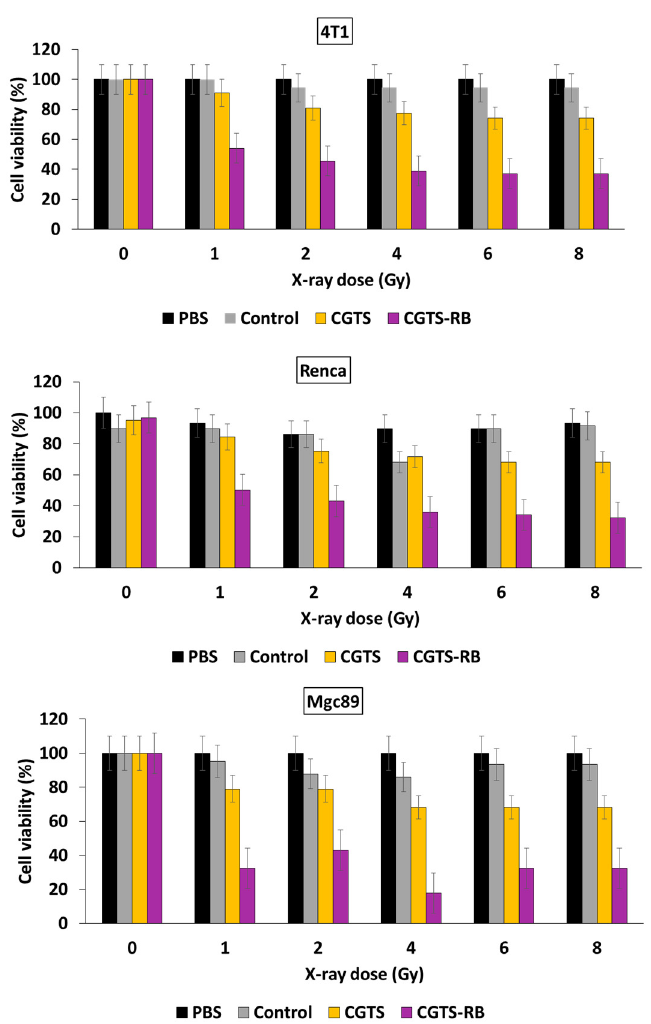
Figure 40. Cell viability of 4T1, Renca, and Mgc89 cells incubated for 24 h with PBS, CGTS and CGTS-RB (50 µg/mL) under different X-ray doses (1 Gy/min). Adapted from Ahmad et al. [107]. In vivo tests were performed on 4T1 tumor-bearing mice. Intravenous injection of CGTS-RB (2 mg/mL, 200 µL) and their X-ray irradiation (160 kV, 25 µA, 6 Gy) showed inhibition of tumor proliferation over 14 days (Figure 41).